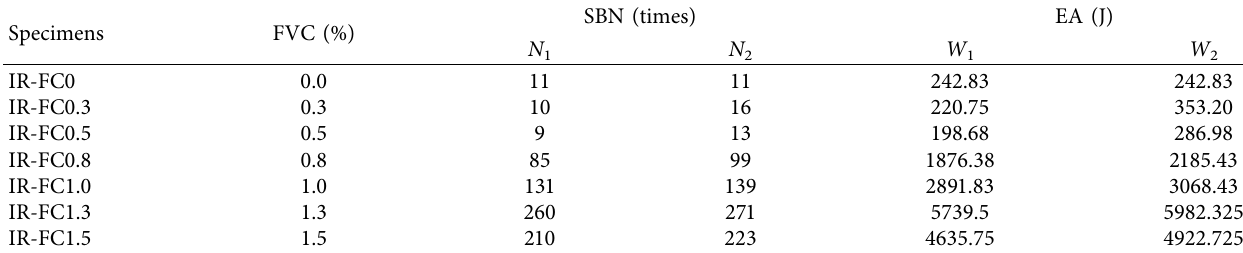
Table 6: ARGFRC impact resistance